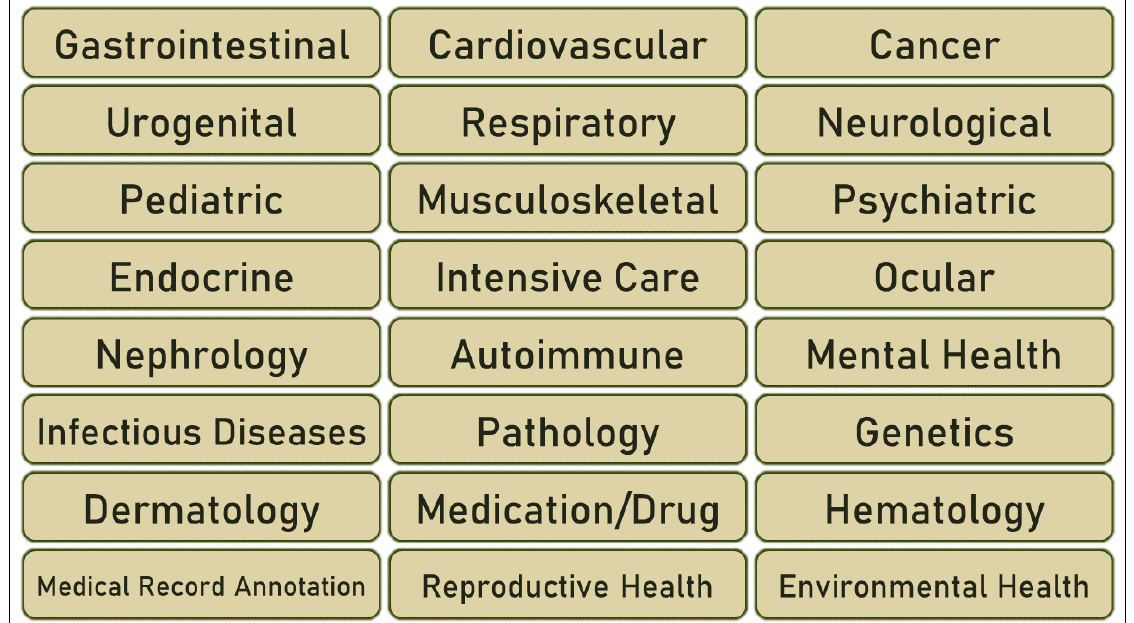
Figure 5. Healthcare sectors where Multimodal ML has been implemented so